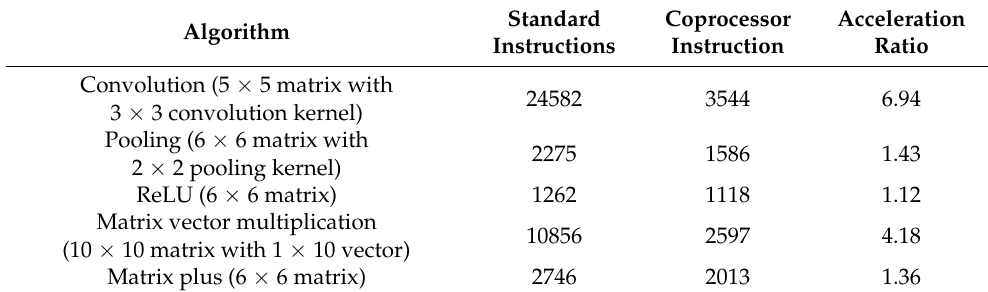
Table 3. Number of execution cycles.